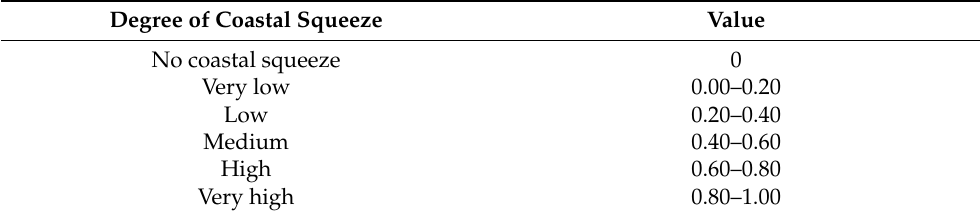
Table 12. Degree of coastal squeeze, taken and modified from